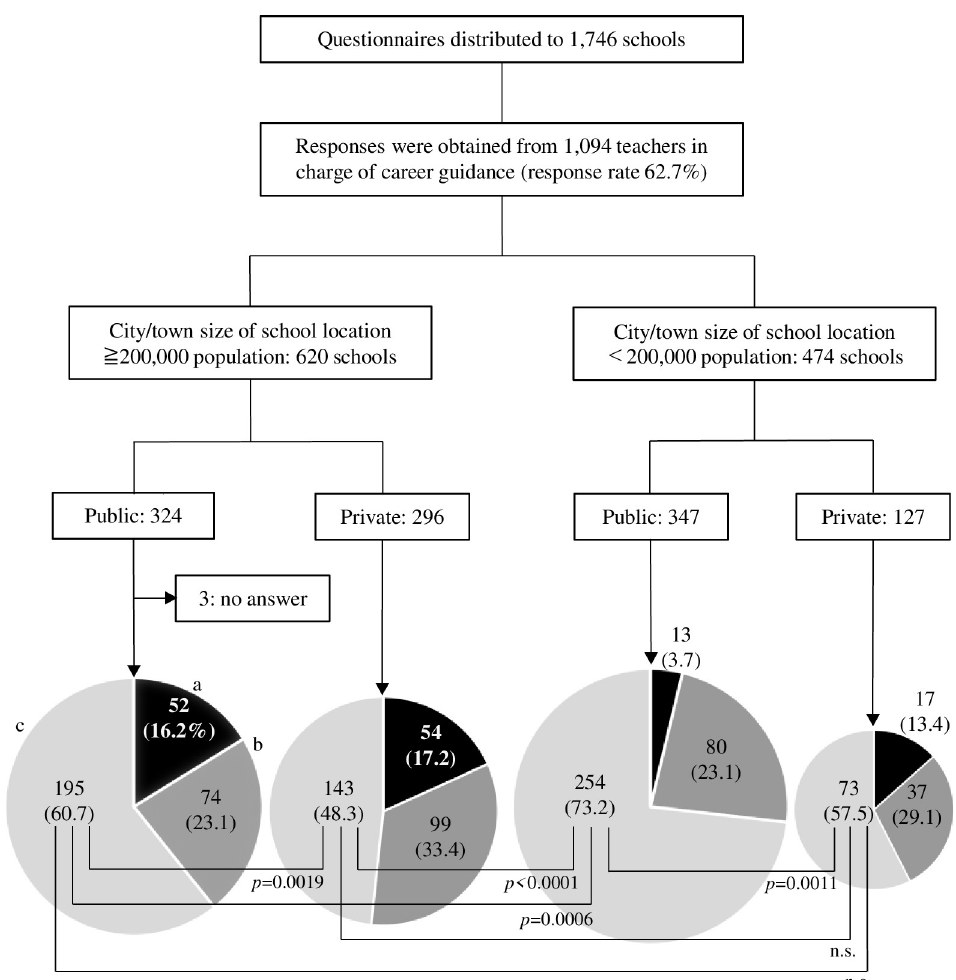
Fig 1. Number of students enrolled in medical school by location and the type of high school. a The black portion of each pie chart shows the respondents (in numbers and percentages) who answered that the average number of students enrolled in the medical school per year was 10 or more. b,c Moreover, the dark gray portion of each pie chart shows the number was 2–9, whereas the light gray portion shows the number was one or